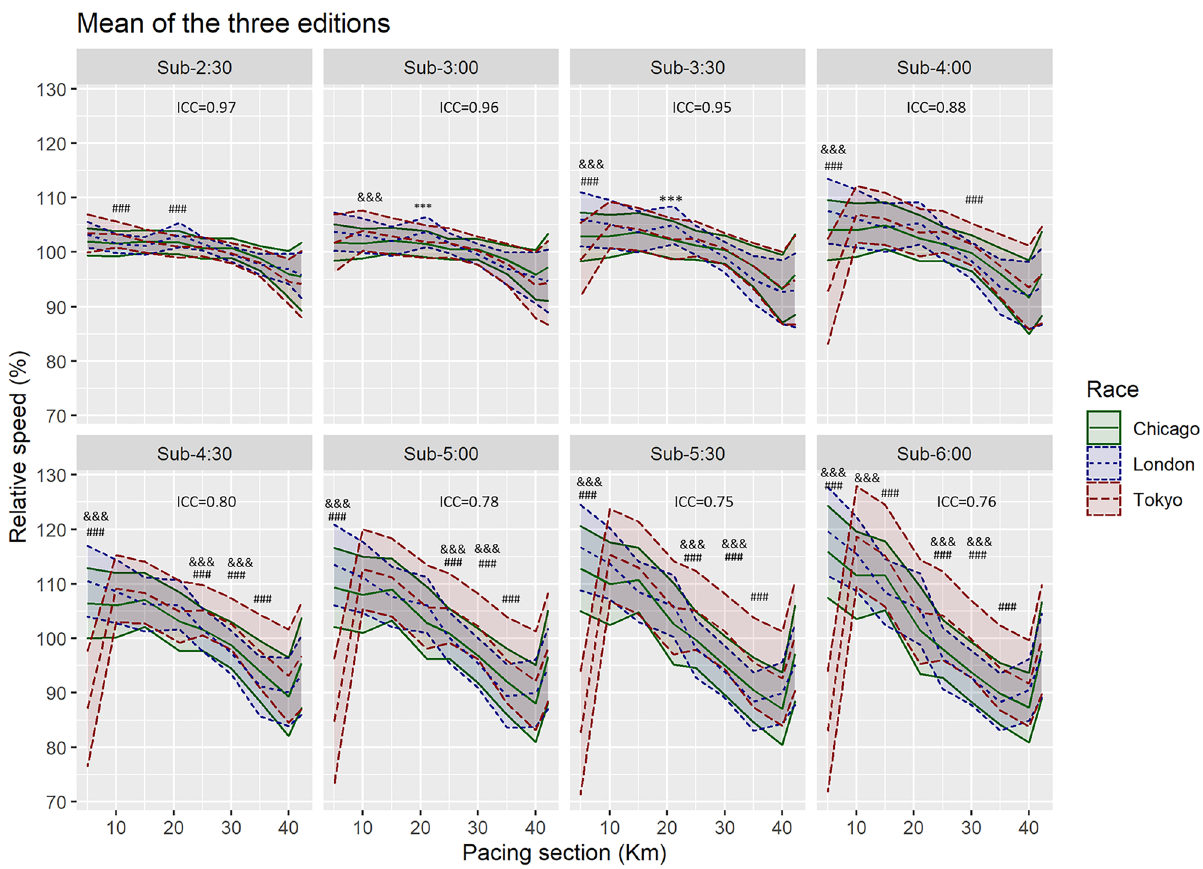
Figure 3. Mean and standard deviation of relative speed (percentage of average speed for the full marathon) at the different pacing sections of the marathons analyzed. The intraclass correlation coefficient (ICC) between marathons is shown for each of the runner time categories. Differences ( p < 0.05 and ES > 0.8) between marathons are shown using symbols (*** p < 0.001 and ES > 0.8 between Chicago and London; &&& p < 0.001 and ES > 0.8 between Chicago and Tokyo; ### p < 0.001 and ES > 0.8 between London and